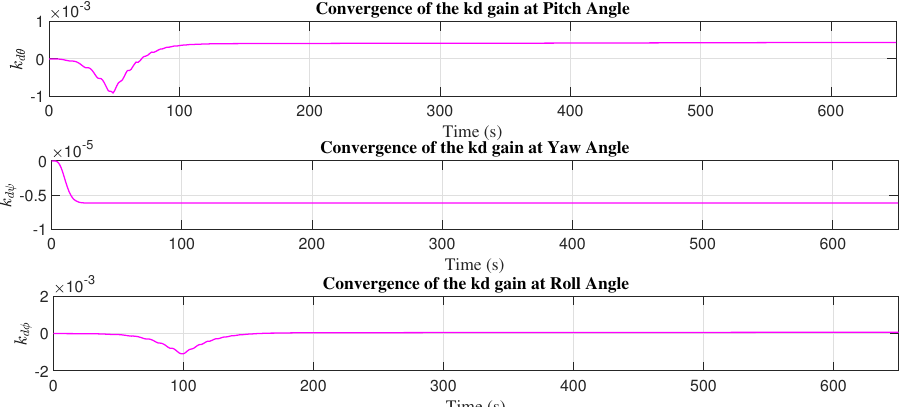
Figure 17. Convergence ˆ k p with MIT rule with sliding modes (MIT-SM).